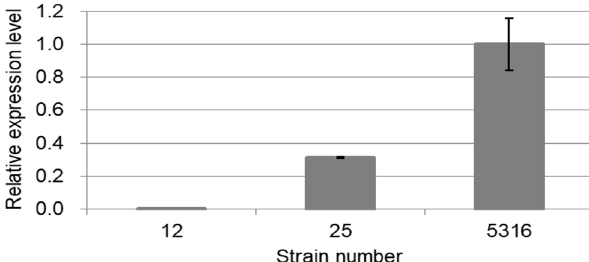
Figure 4. The relative expression levels of Pf-49487 in strains 12, 25, and 5316. Error bars indicate SE of triplicate analyses of two independent samples.